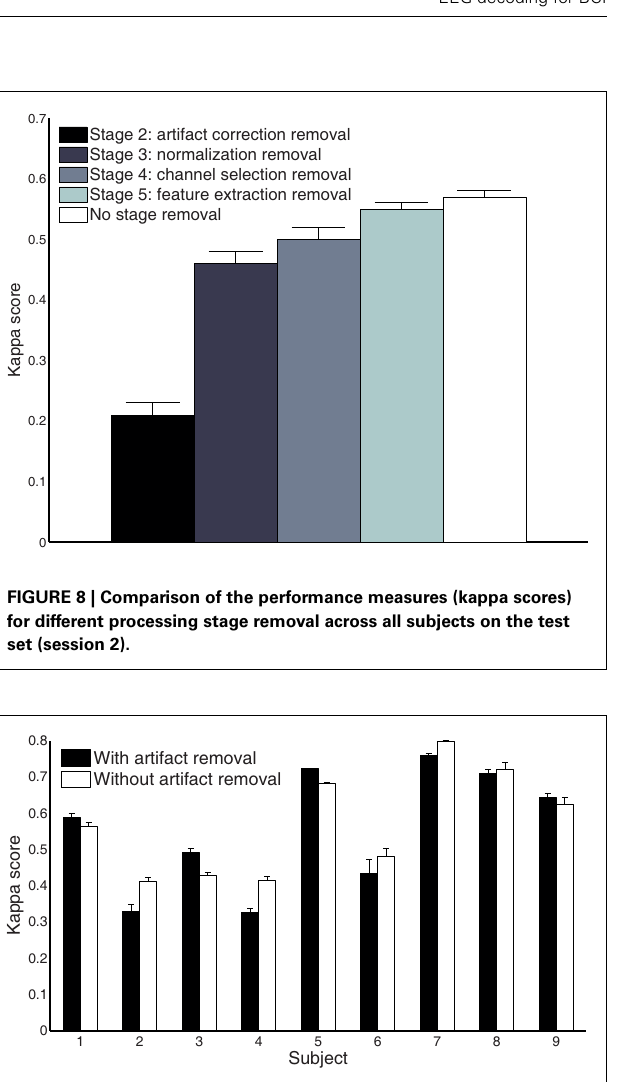
FIGURE 9 | Comparison of the performance measures (kappa scores) for the whole processing framework with and without artifact removal for subject 1 to 9 on the test set (session